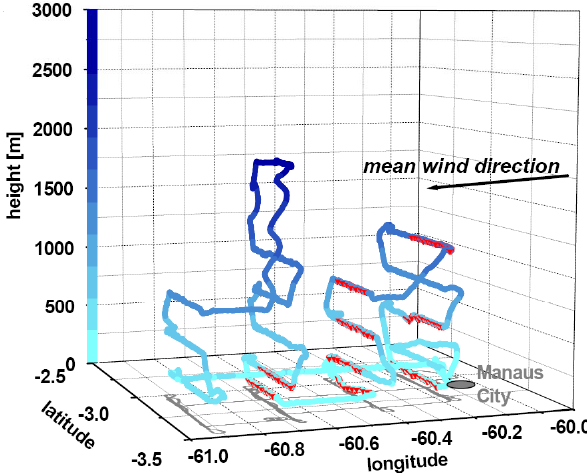
Fig. 2. 3-D plot of Flight #18 on 19 July 2001. After takeoff at the airport of Manaus the flight pattern was set up as a Lagrangian experiment with a series of stacked horizontal profiles (with 3–6 crosswind transects each) in the urban outflow at successive dis- tances downwind of Manaus City (10, 40, 70 and 100km). The flight altitude is colour-coded in blue (z-axis). Red lines indicate the VOC cartridge sample intervals within some of the plume tran- sects. The grey line is the XY-projection as in Fig.